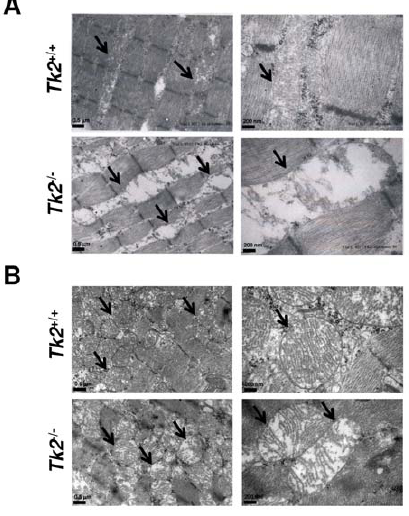
Figure 1. Tk2 + / + and Tk2 2 / 2 mice skeletal muscle and heart mitochondria ultrastructure. Transmission electron microscopy images of skeletal muscle ( A ) and heart ( B ) sections isolated from wild-type ( Tk2 + / + ) and Tk2 knockout ( Tk2 2 / 2 ) 14 days-old mice. Mitochondria are indicated with solid arrows in the pictures.